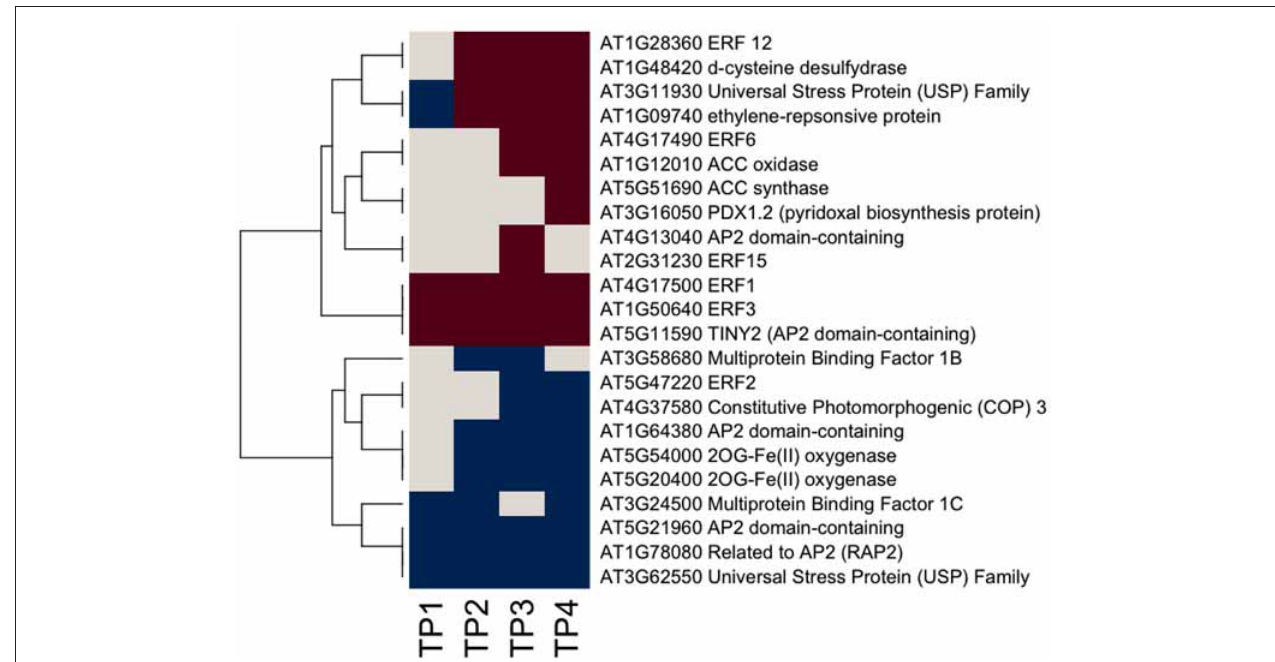
expression changes, blue cells represent significant negative changes, and off-white cells represent no change or no statistically significant change.